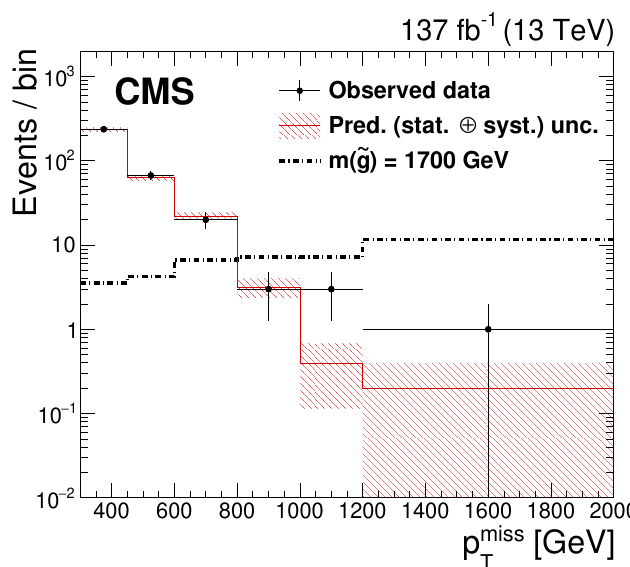
Figure 8 . Observed data and background prediction as functions of p miss associated with each data point represents the width of the corresponding bin. The red hatched region denotes the expected statistical and systematic uncertainties added in quadrature. Expected signal contribution for one example mass point is also